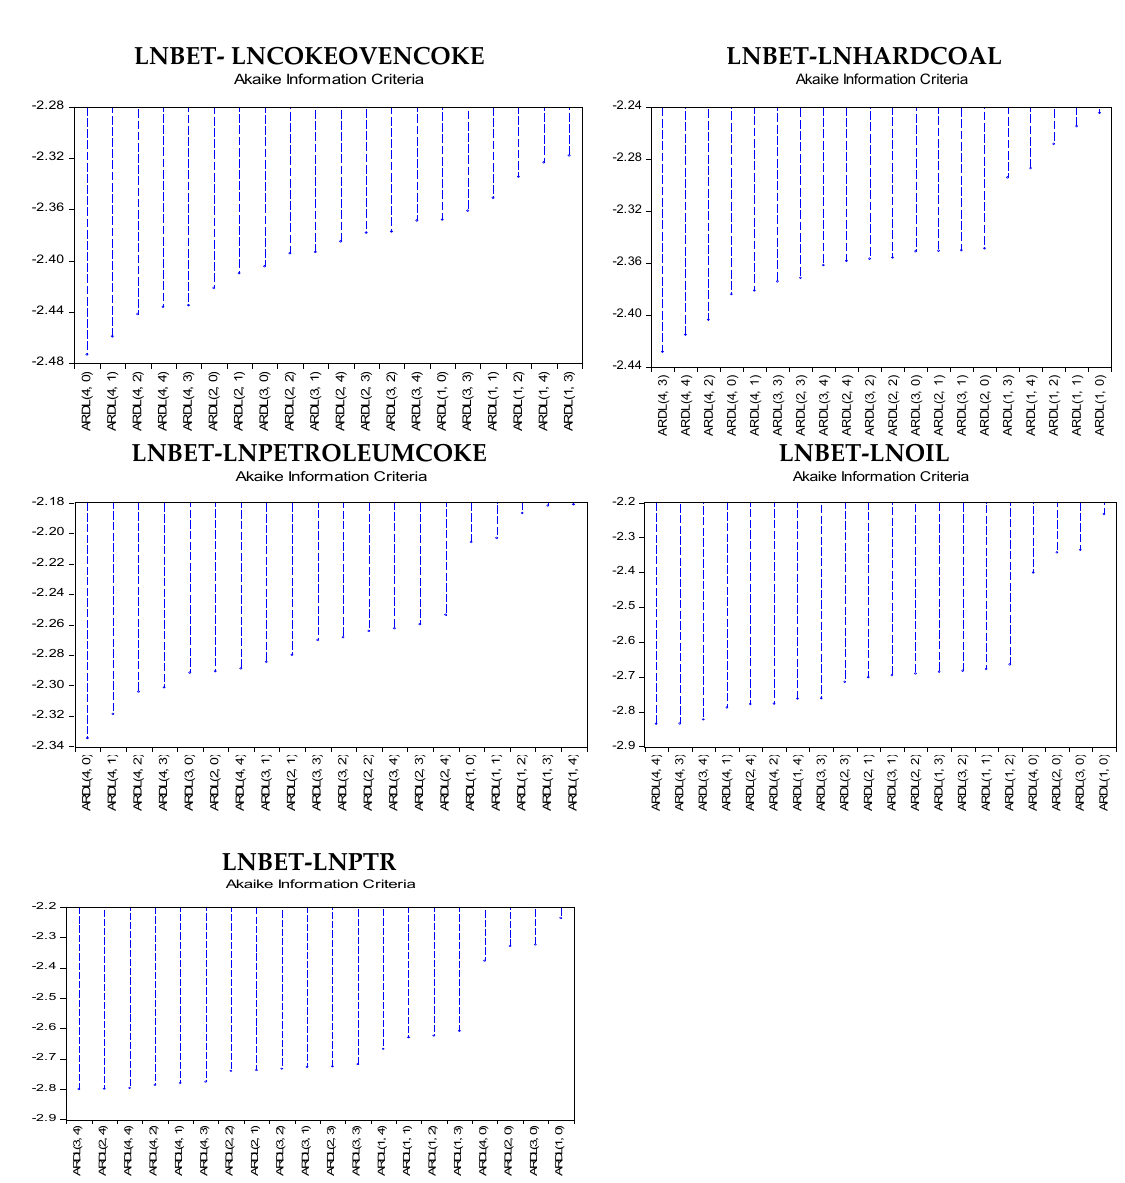
Figure 3. Optimal lags. Source: Authors’ work.